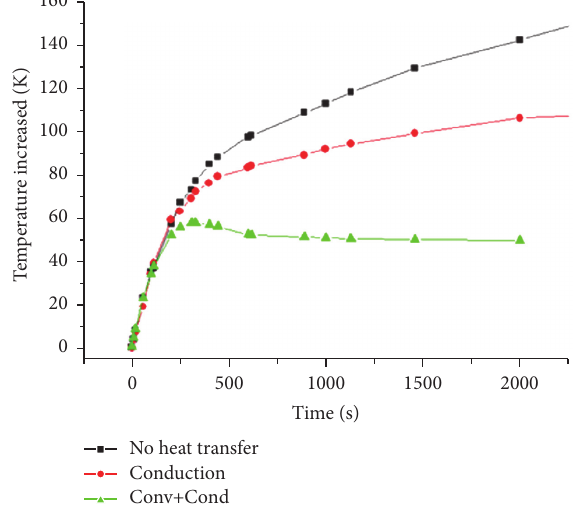
Figure 9: Predicted thermosiphon maximum temperature for different parametric studies for a Trip 1 initiating